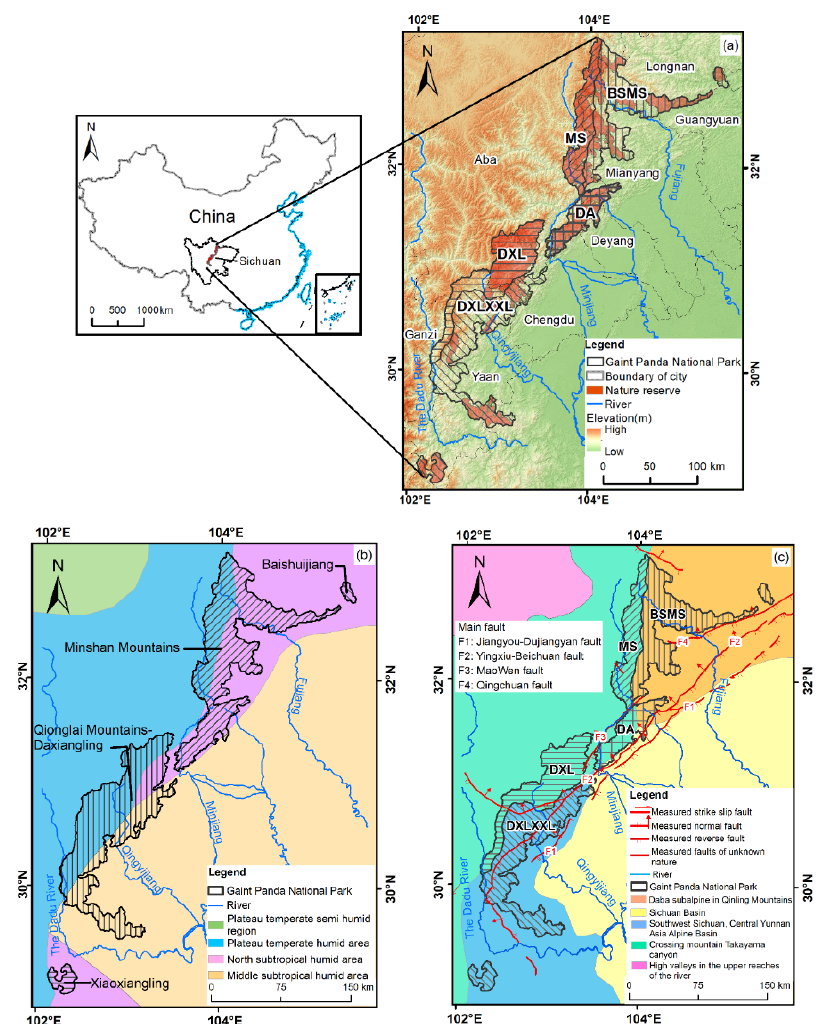
Figure 1. ( a ) Location of the study area. ( b ) Climatic zoning. ( c ) Geomorphological zoning.